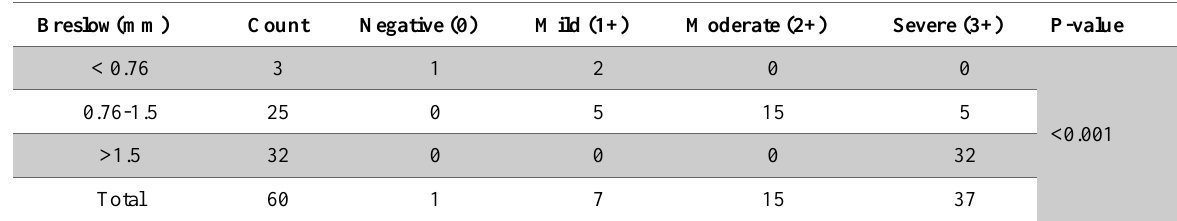
Table 2. Tumor thickness and SI score relationship